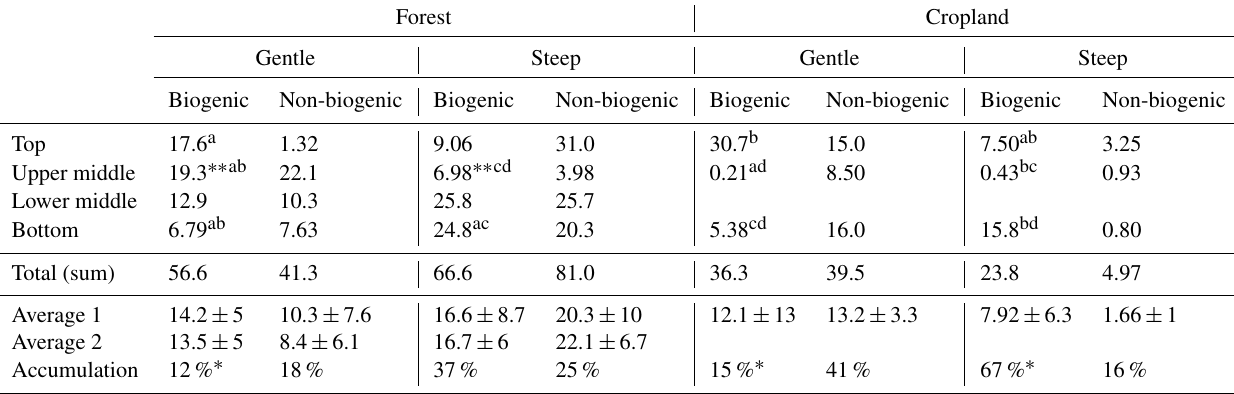
Accumulation 12% ∗ 16% a , b , c , d Averages by row showing the same letter are statistically different ( p< 0 . 005 ). ∗ Difference between the top and the bottom pit averages from that slope is statistically significant ( p< 0 . 005 ). ∗∗ Statistical comparison between middle position between forest sites and cropland sites were calculated taking the two middle pits (upper and lower middle) for the